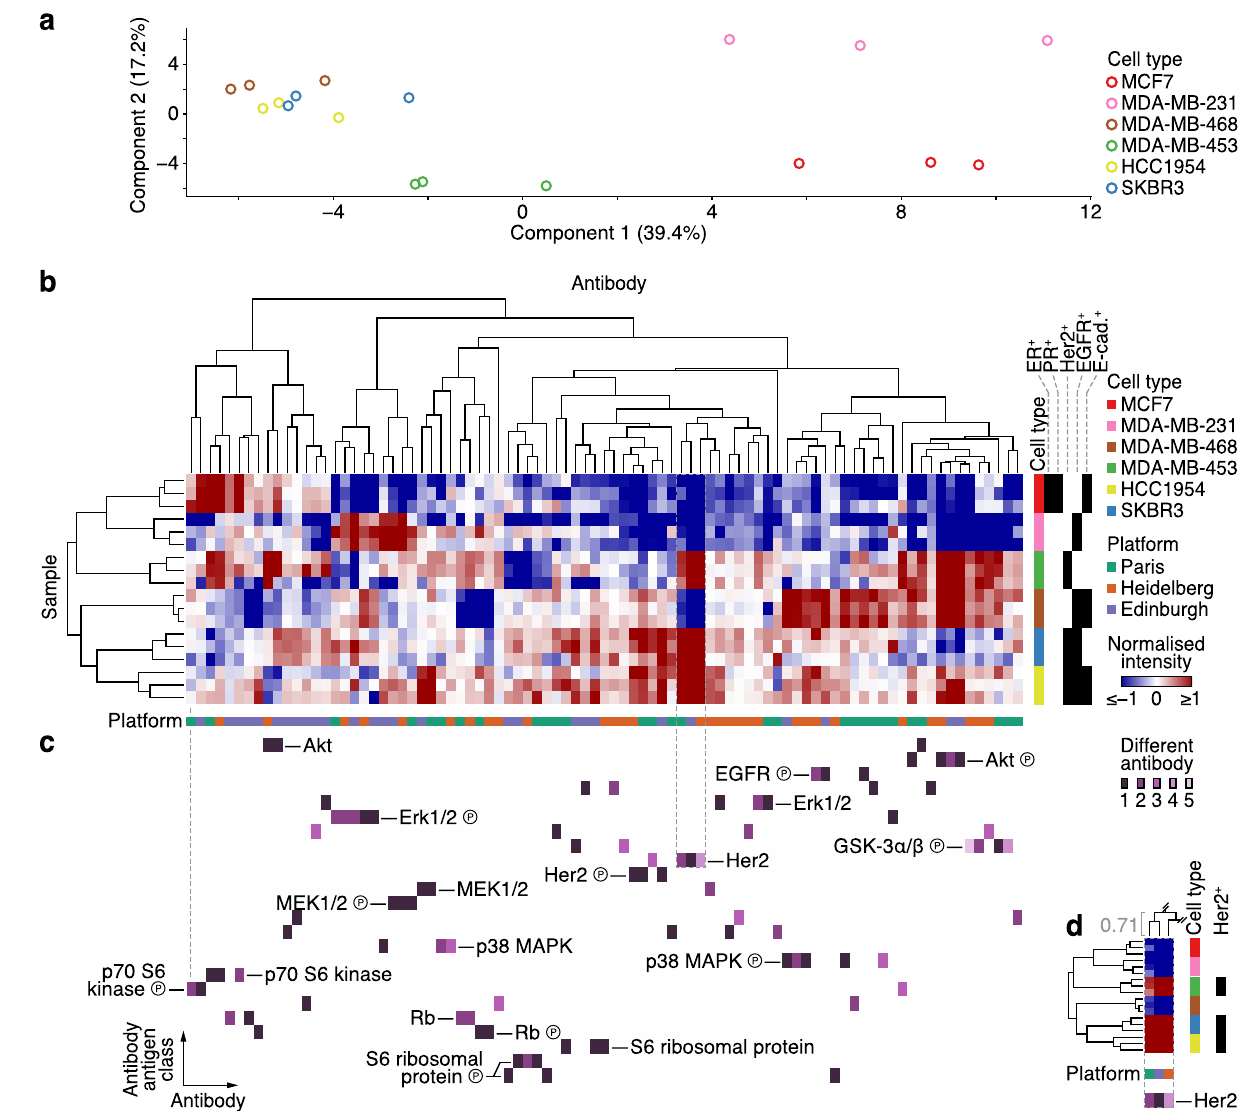
Figure 2. Integrative analysis of multi-platform RPPA data. ( a ) Principal component analysis of integrated multi-platform RPPA data of six breast cancer cell lines cultured under control conditions. ( b ) Integrated multi- platform RPPA data were clustered on the basis of antibody-wise and sample-wise dissimilarities (Spearman rank correlation coefficient-based distance). Annotation bars indicate cell type, cell type receptor status and RPPA platform. ( c ) Clustered antibody antigen map for all antibodies used in the integrative analysis. The map is aligned with the hierarchical clustering results in ( b ) [grey dashed line above the left-most antibody indicates alignment of the first antibody (column) end-node]. Distinct antibodies that target the same antigen class (unique antibody identifiers) are indicated by different shades of purple. Antibody antigen classes are ordered alphabetically for clarity. ( d ) Exemplar of clustered antibodies that recognise Her2, indicated by grey dashed box in ( b ) and ( c ). Antibodies used by all three RPPA platforms clustered in antibody–antibody antigen space. Spearman rank correlation coefficient of the cluster column node is shown in grey. All three platforms used different antibodies that recognise Her2 (antibody identifiers for Paris, Her2_b; Heidelberg, Her2_d; Edinburgh, Her2_a). For further details, see Supplementary Fig. S2 and Supplementary Table